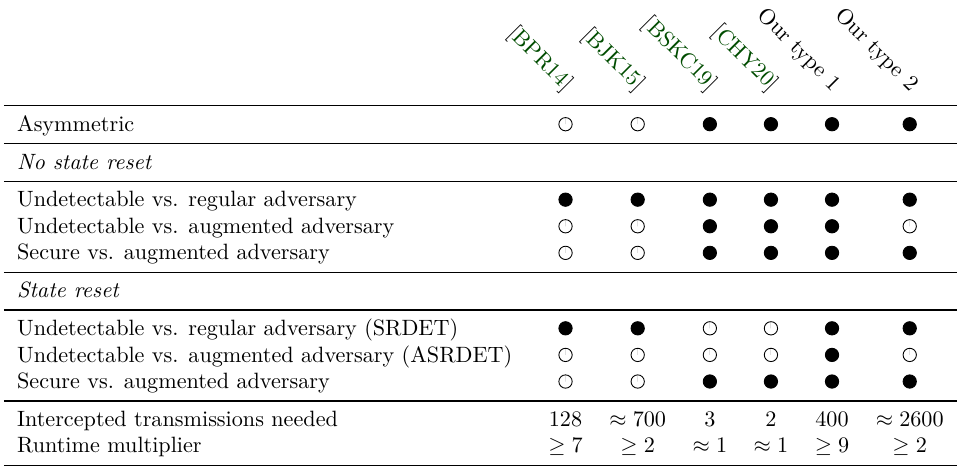
Table 1: Comparison of properties of various ASAs. An augmented adversary refers to an adversary in possession of the embedded subversion key. If applicable, | k | =